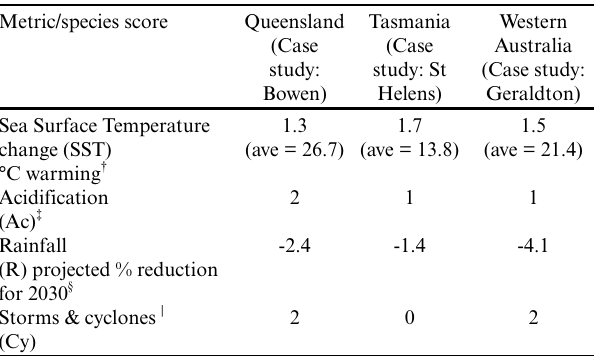
Table 3 . Metrics used in the calculation of the climate exposure (CE) for each state using historical and projected climate data. Acidification and storms and cyclone metrics calculated using expert opinion of the authors (physical oceanography expertise) where 2 = worst impact, 1 = medium impact, 0 = low